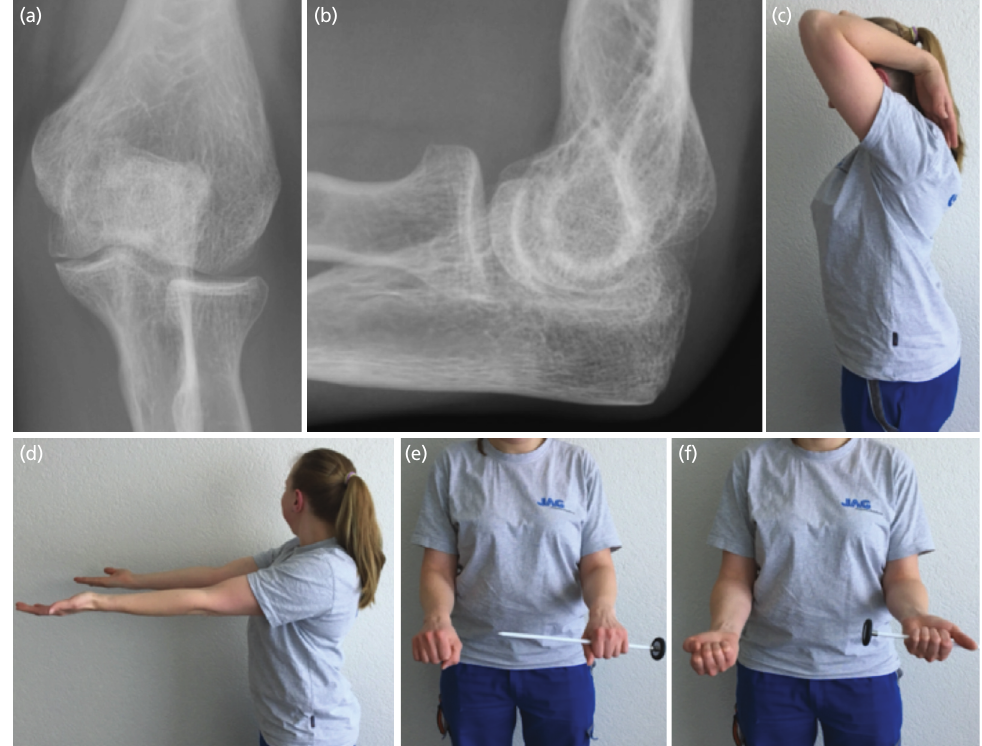
Fig. 3: Radiographic and clinical result 10 years after tumour resection and autologous bone grafting. (a) Anteroposterior and (b) lateral radiographs of the elbow show a normal joint without tumour recurrence and without joint space narrowing. Photographs show normal (c) flexion, (d) extension, (e) pronation and